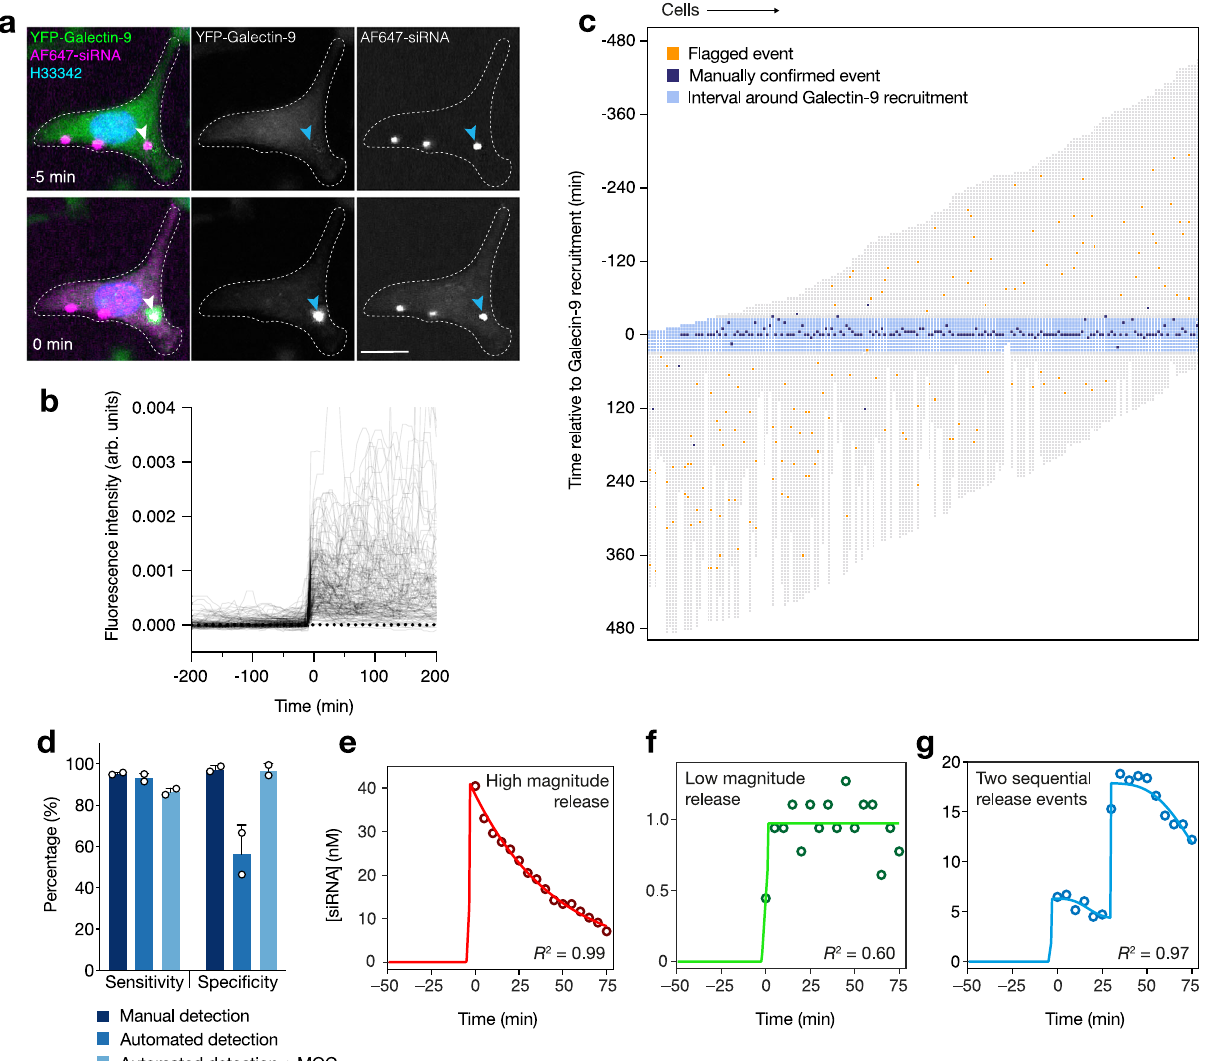
Fig. 3 | Automated detection and absolute quanti fi cation of cytosolic siRNA during lipid-mediated delivery. Airyscan confocal imaging of HeLa cells expres- sing YFP-galectin-9 every 5min during treatment with lipoplexed AF647-siRNA. a Endosomal release and cytosolic dispersion of AF647-siRNA, coinciding with the recruitment of YFP-galectin-9 to the lipoplex-containing vesicle (indicated by arrowheads). The scale bar is 20 µ m. b Measurements of cytosolic AF647-siRNA in single cells, aligned in time so that t =0 is the fi rst imaging timepoint with detectable de novo YFP-galectin-9 recruitment to lipoplex-containing vesicles. c Traces of individual cells (columns) with the recruitment of YFP-galectin-9 to vesicles containing siRNA-lipoplex, indicating the performance of the automated eventdetectionincombinationwithmanualqualitycontrol.Celltracesarealigned in time with t =0 being the fi rst frame with detectable galectin-9 recruitment. For a – c , N =187cellsfromtwoindependentexperiments. d Performanceofmanualand automated detection of endosomal siRNA release. Detection sensitivity and